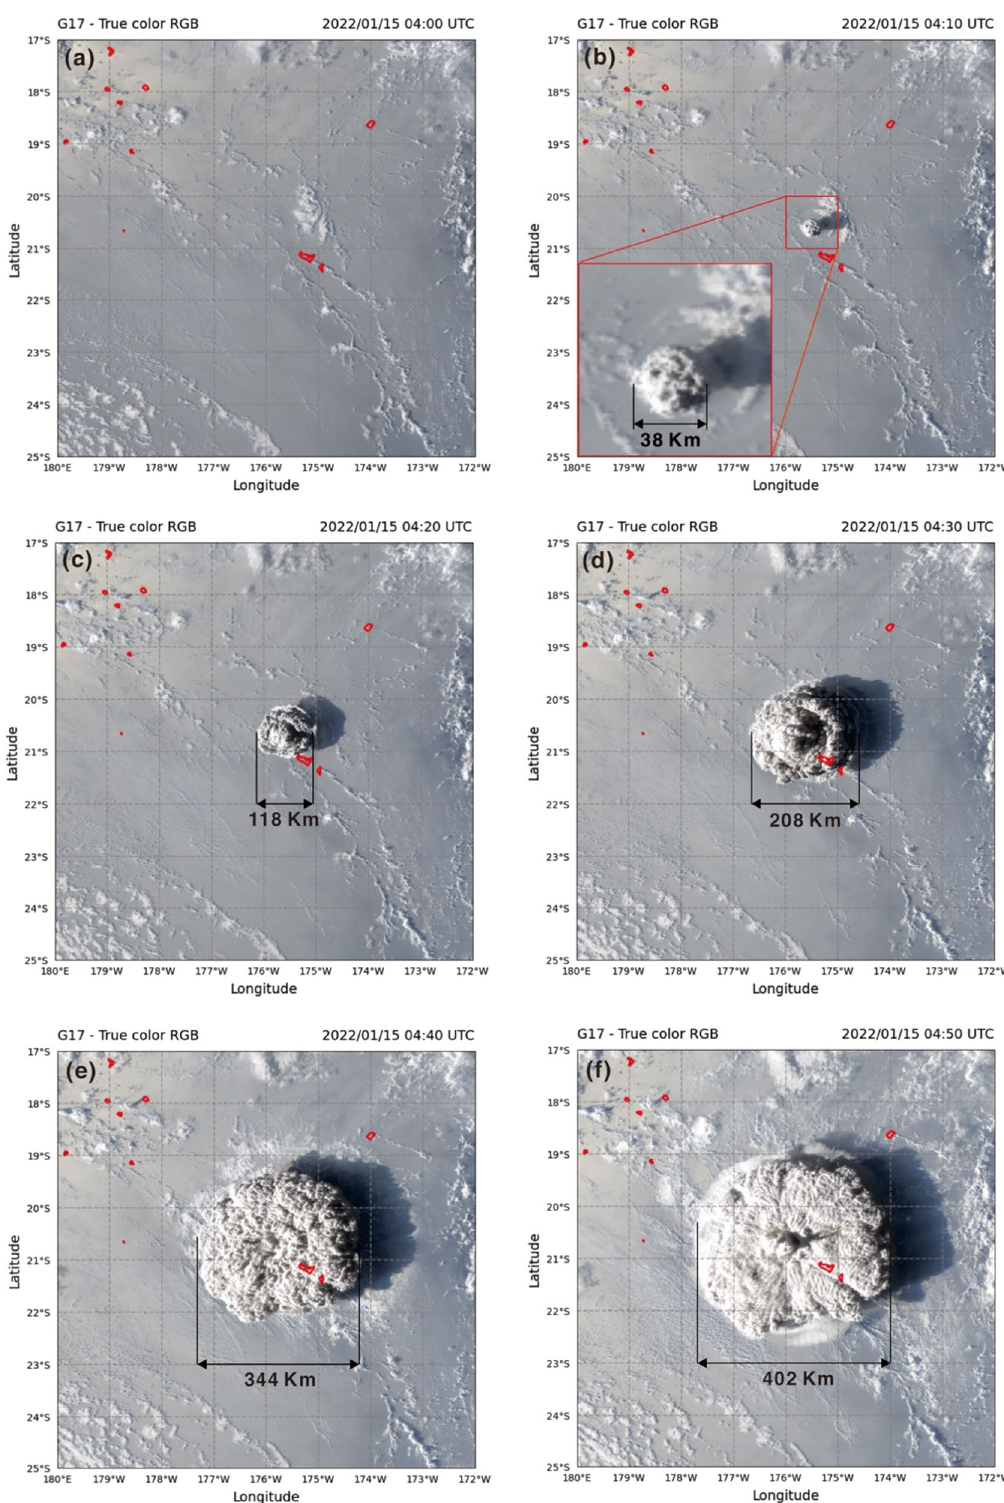
Fig. 9 True color RGB using GOES-17 from 04:00 to 04:50 on 15 January 2022. ( a ) 2020/01/15 04:00 UTC, ( b ) 2020/01/15 04:10 UTC, ( c ) 2020/01/15 04:20 UTC, ( d ) 2020/01/15 04:30 UTC, ( e ) 2020/01/15 04:40 UTC, ( f ) 2020/01/15 04:50